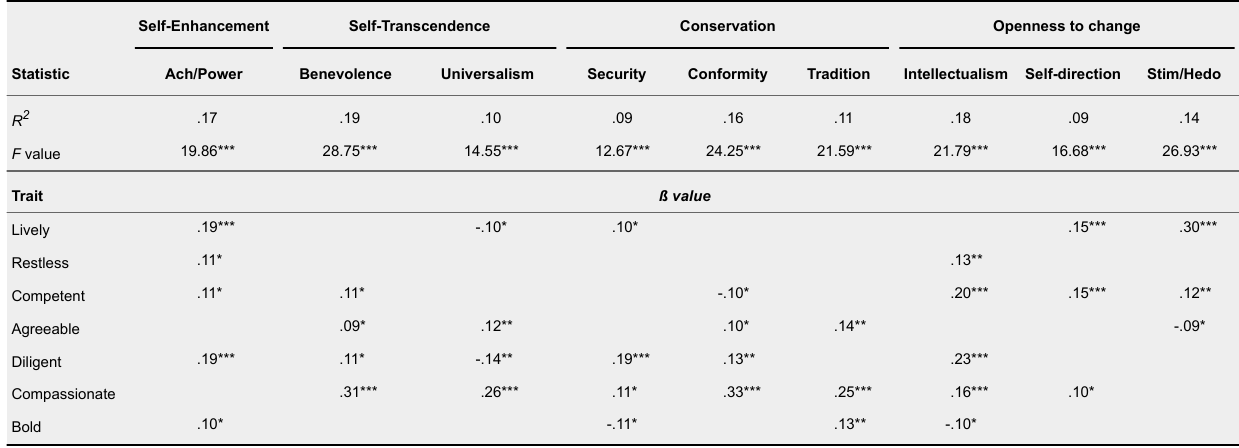
Regression Analysis of Nine Value Factors on Seven